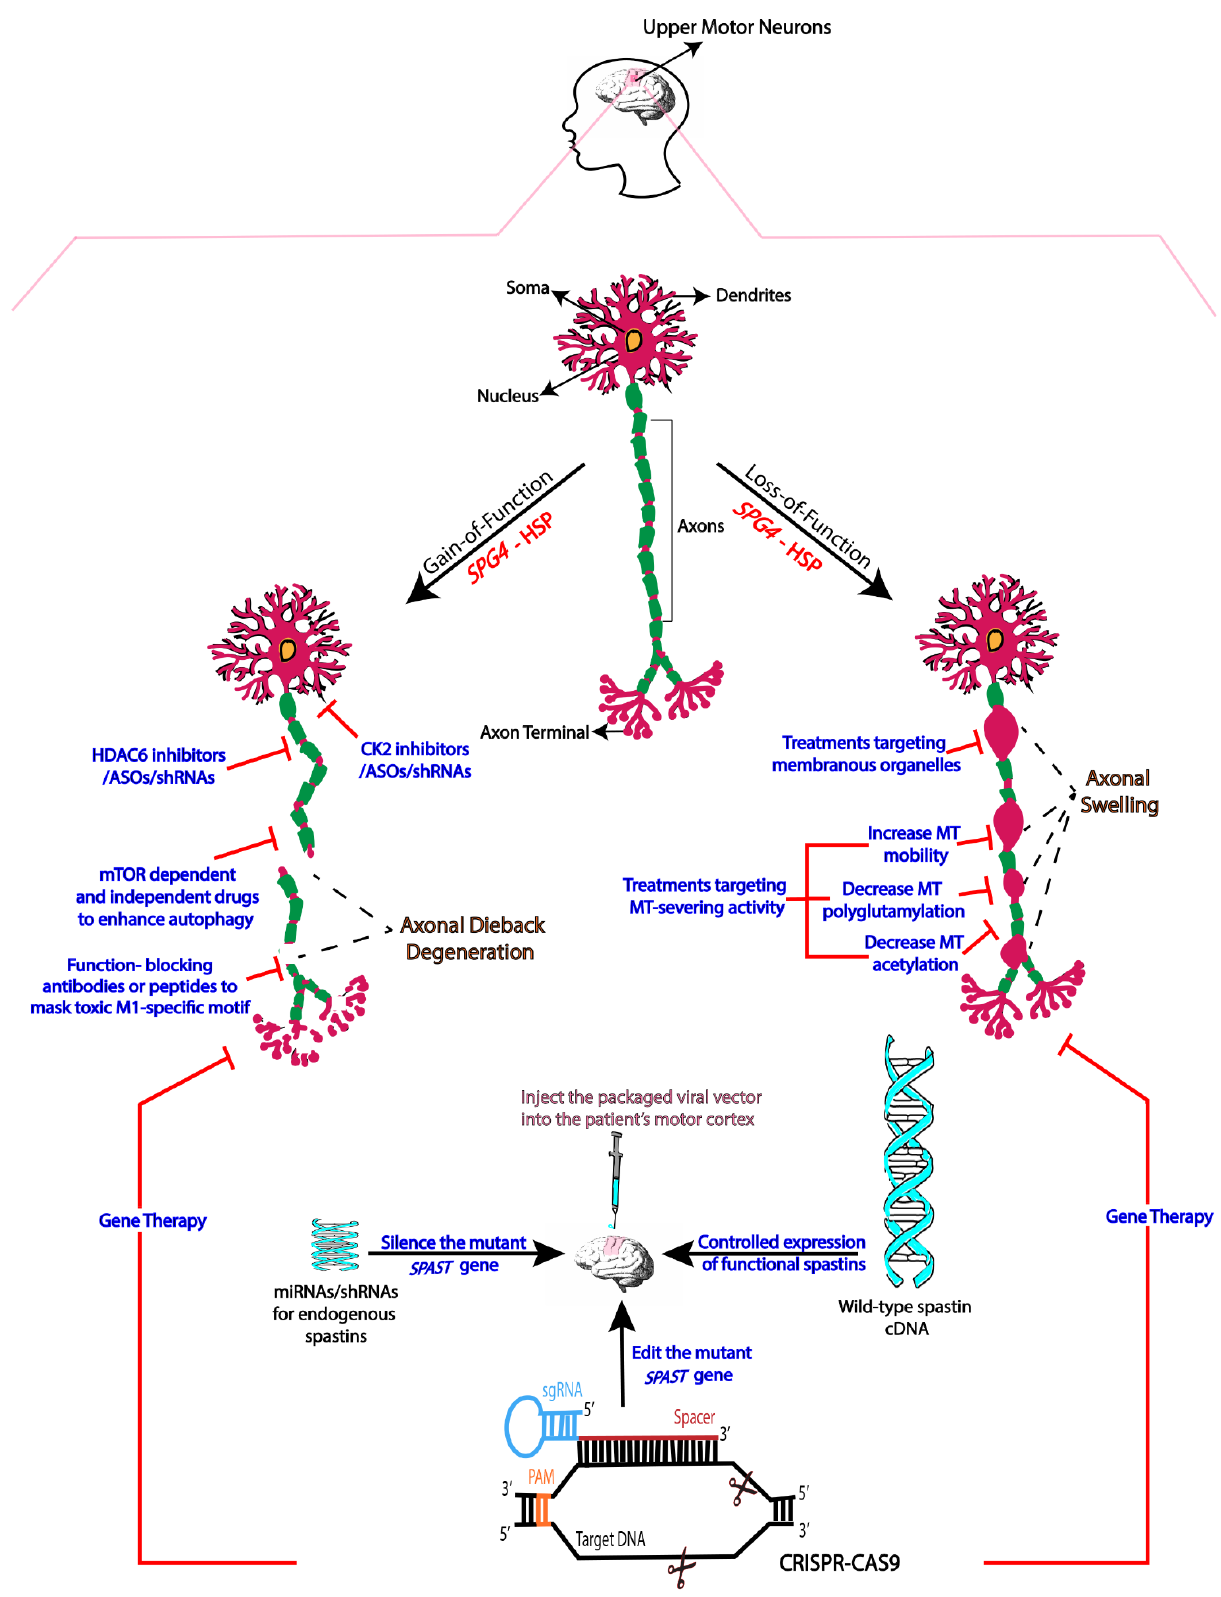
Figure 1. Therapeutic approaches for targeting mechanistic components of SPG4 -HSP. Schematically displayed in the figure are gain-of-function and loss-of-function components of SPG4 -HSP, and various potential treatment interventions discussed in this article that might target a specific component. Microtubule (MT).